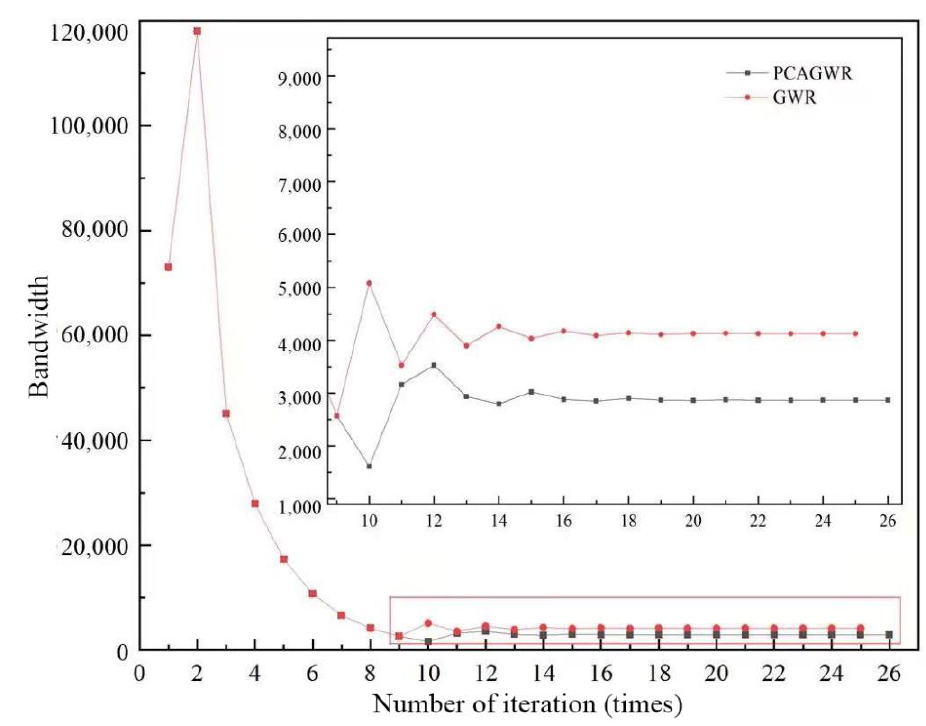
Figure 12. Bandwidth iteration process diagram based on a single spatial non-stationarity scale.